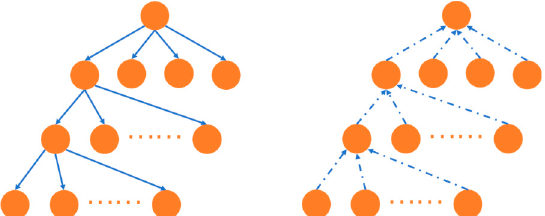
Figure 1. The propagation and aggregation of rumors. The orange nodes represent tweets, and the root node is the source tweet. The left part shows the top-to-bottom propagation structures of rumors, and the right part shows the bottom-to-top aggregation structure of public opinions during the spread of rumors.